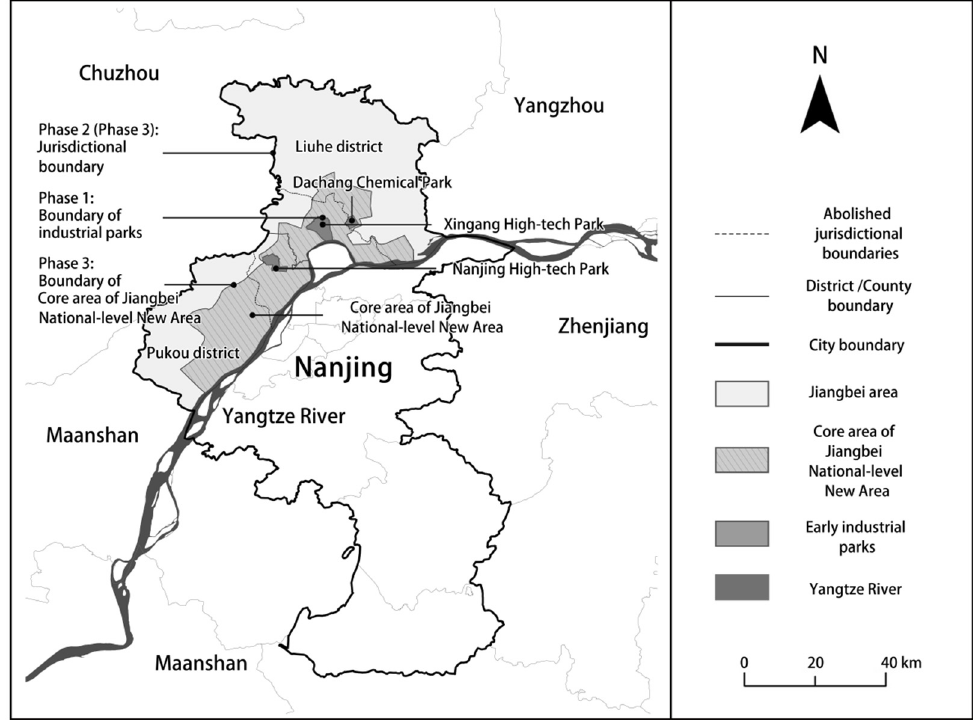
Figure 7. Evolution of physical layouts of Jiangbei development in Nanjing by development zones.